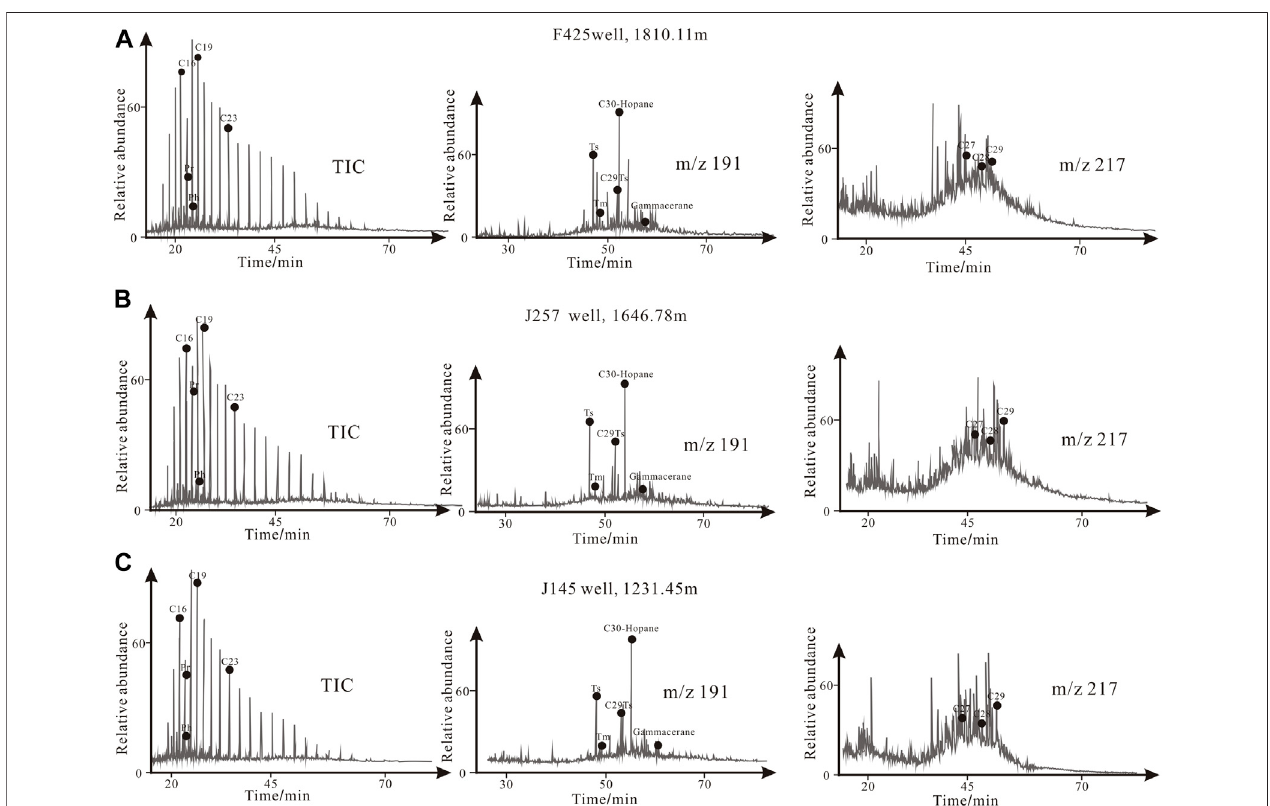
FIGURE 7 | The n-alkane gas chromatograms of saturated hydrocarbon in different organic matters.